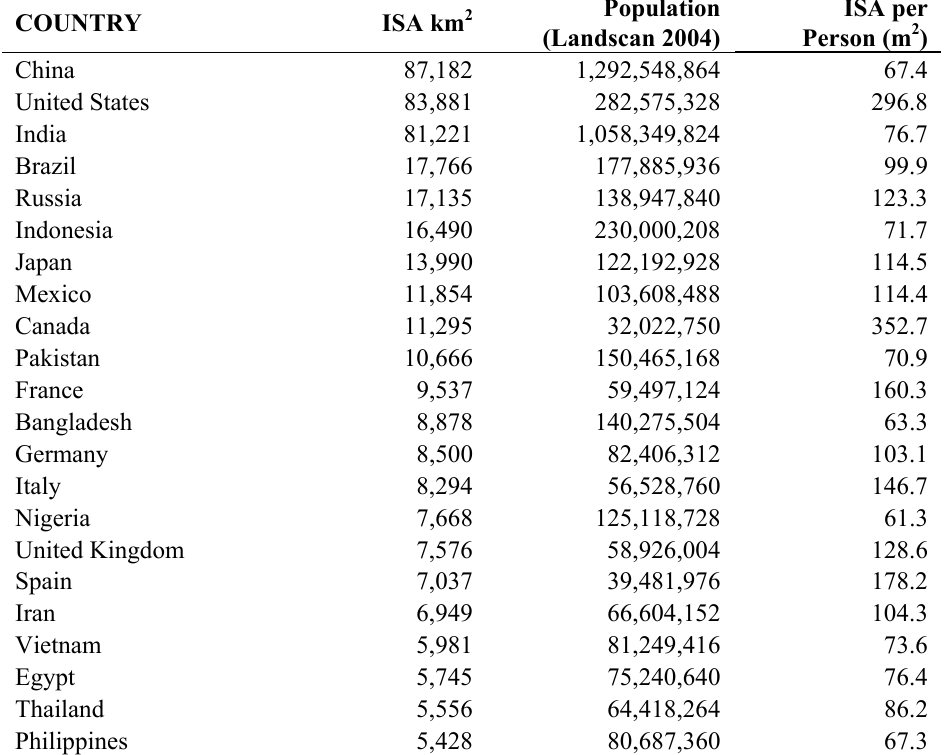
Table 1. Top Hundred Countries in Terms of Constructed Impervious Surface